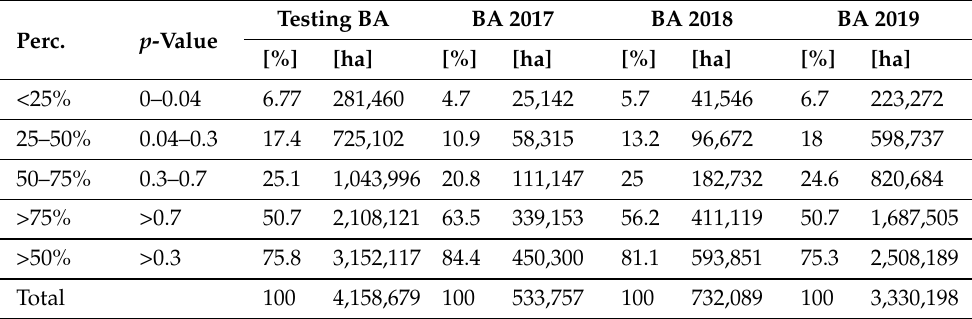
Table 3. Model validation evaluated by computing the predicted burning area (BA) for different percentile classes (Perc.) falling within the testing burned areas, estimated globally (Testing BA), and for each single year (2017, 2018, 2019). Perc.